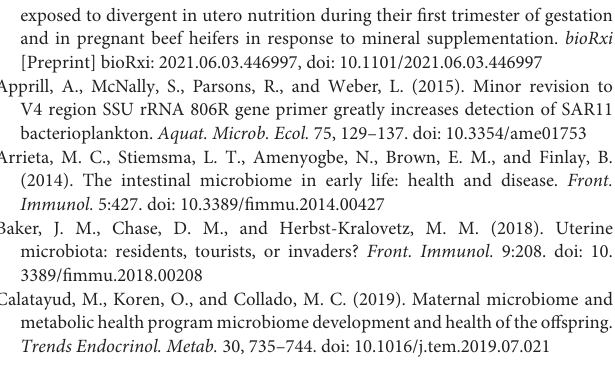
Supplementary Figure 1 | (A) The anatomic location of amniotic and allantoic fluid, and fetal placenta (cotyledon), (B) the collection of the fetal fluids, and (C) the fetal intestine of the 83-day-old calf fetuses. Supplementary Figure 2 | Heatmap showing the 100 most abundant OTUs